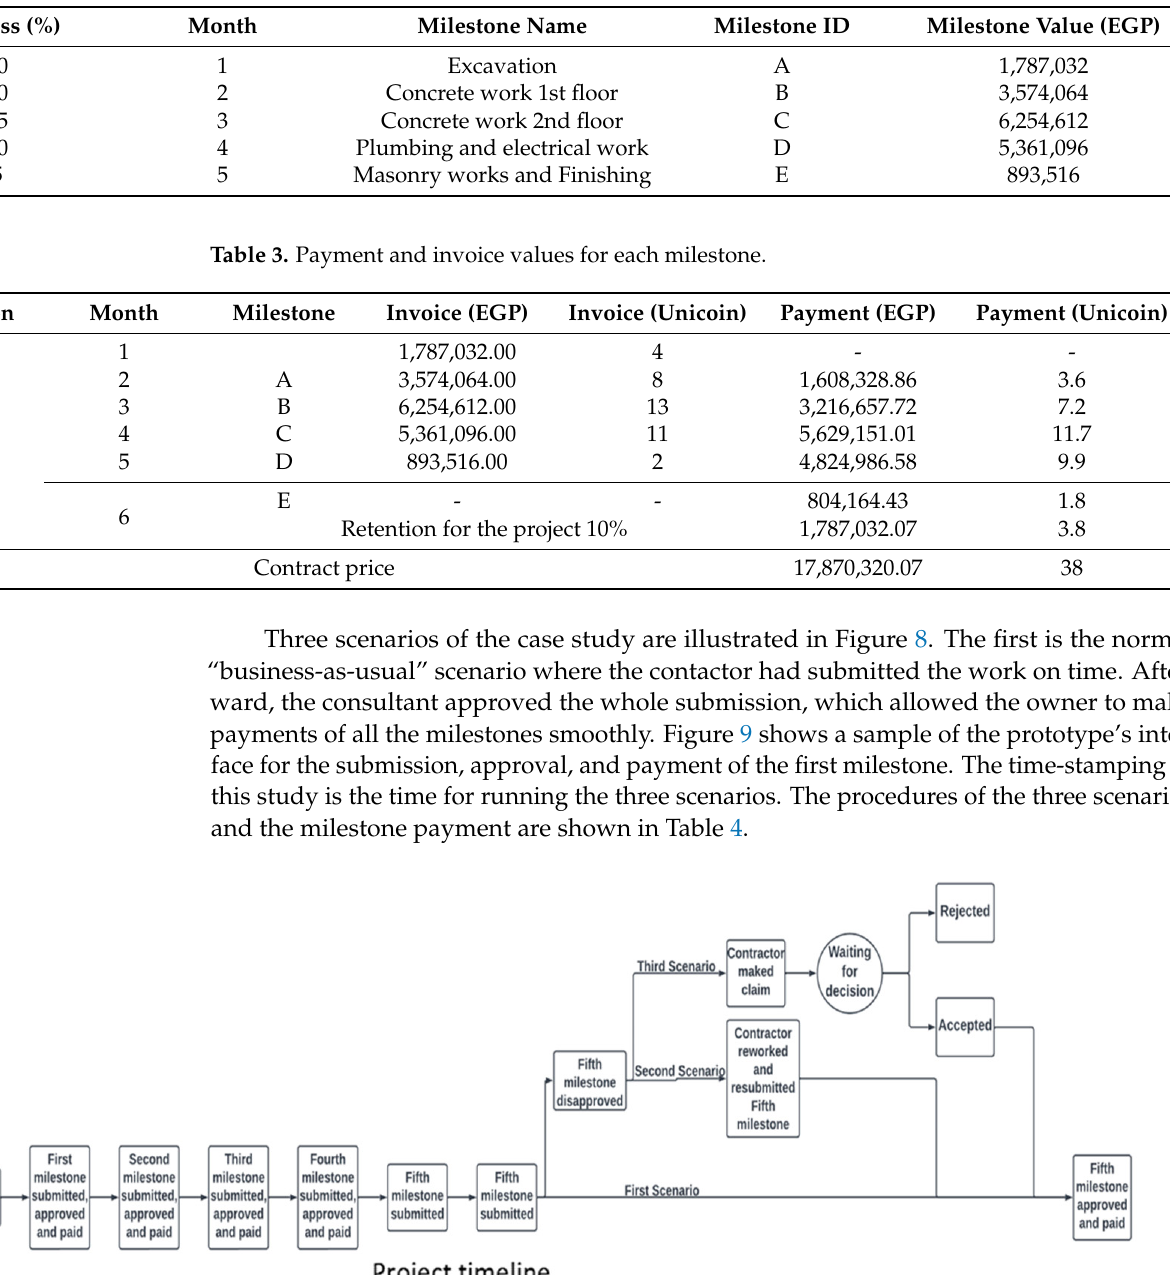
Table 2. Milestones’ values at different progress percentages for the case study.